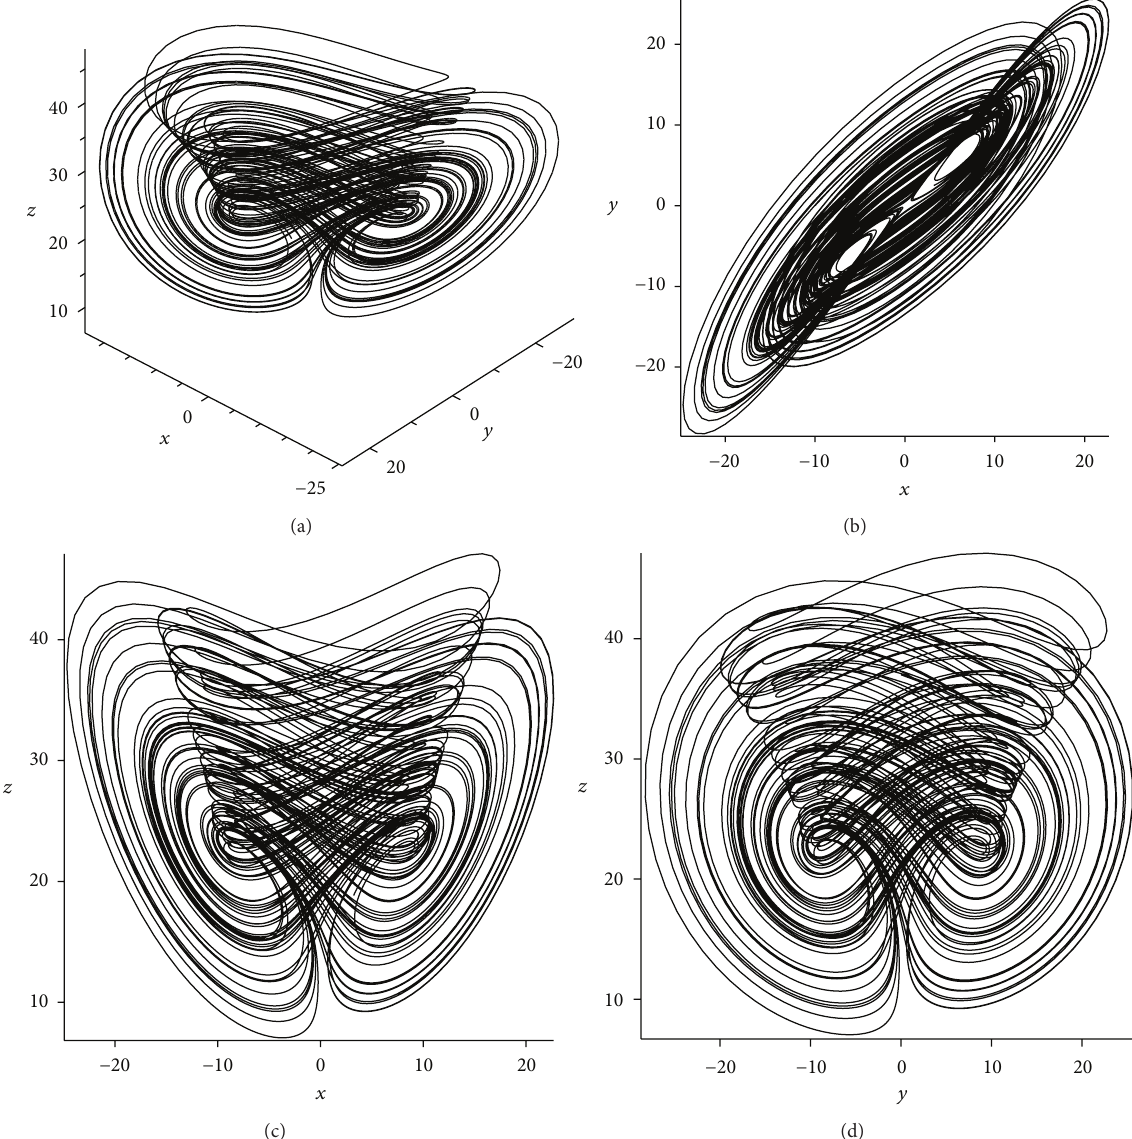
Figure 4: Typical dynamical behavior of three-dimensional Chen system. (a) Projection in (𝑥,𝑦,𝑧) space; (b) projection in (𝑥,𝑦) space; (c) projection in (𝑥,𝑧) space; (d) projection in (𝑦,𝑧)